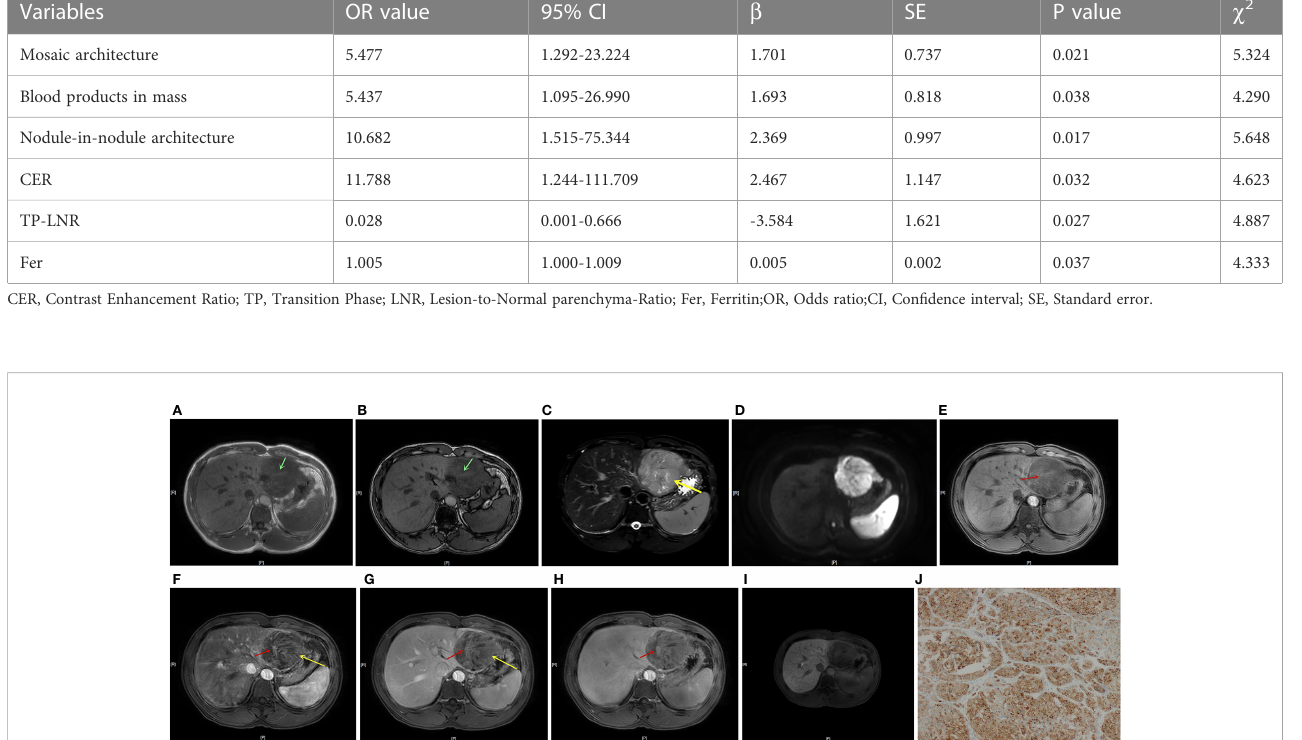
TABLE 5 The multivariable logistic regression analysis for GPC-3 expression. Variables